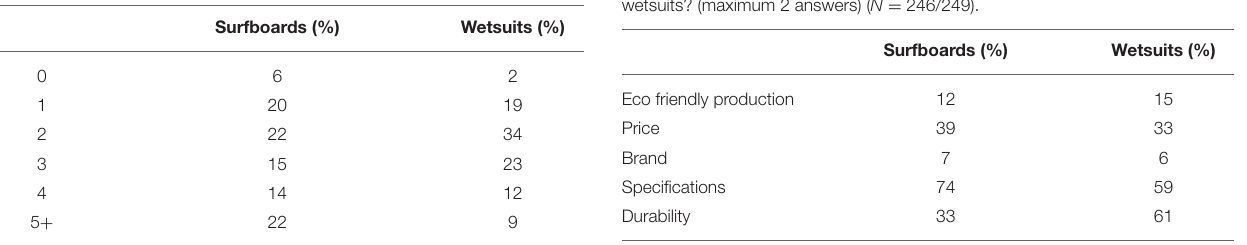
TABLE 2 | How many surfboards and wetsuits do you own? (N = 250).